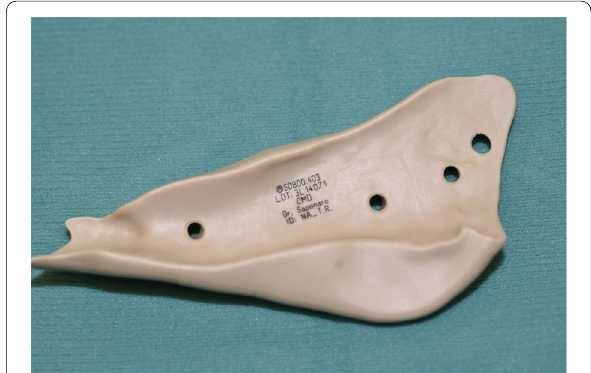
Fig. 3 Case 1: vision of the lower mandibular groove in a PEEK implant; in this case, the implant was planned with an insufficient groove which provided insufficient retention and stability leading to difficulties in the correct positioning of the implant